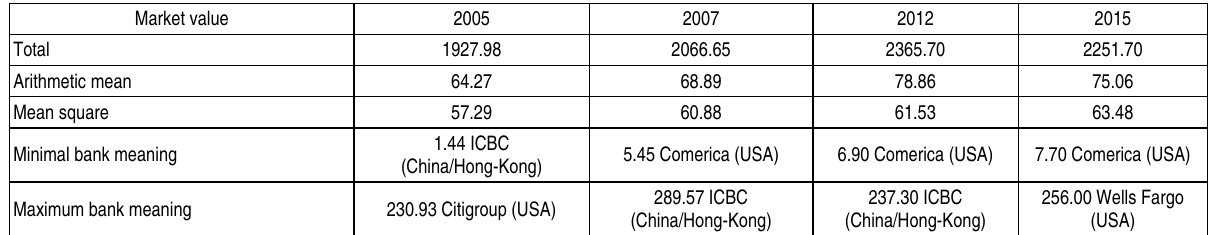
Table 5. The dynamics of market value of thirty major world banks, bln US dollars